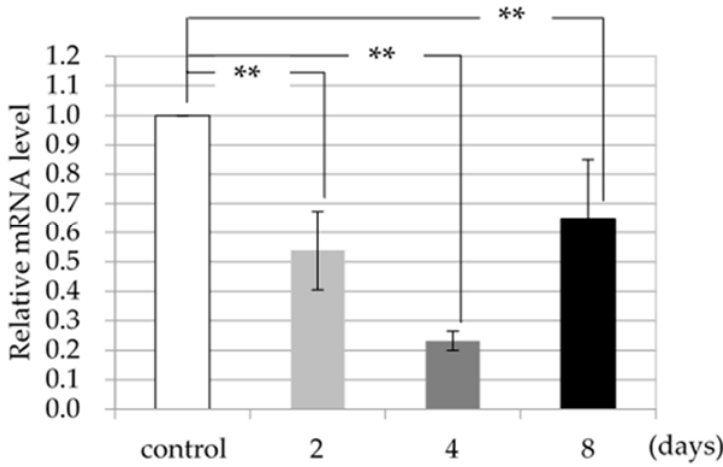
Figure 4. Effect of ISLCs on the gene expression level of IL6 in 3T3-L1 cells 2, 4, and 8 days after differentiation. The IL6 expression level of cultured cells treated with 1.0 mg/mL ISLCs and untreated control cells 2, 4, and 8 days after differentiation was measured by real-time PCR. The cells were cultured in medium containing 1.0 mg/mL ISLCs. The cells in the medium without ISLCs were used as a control. Gene expression was expressed relative to untreated control cells (1.0). The mRNA levels of the target genes were normalized to the values of GAPDH. Values are expressed as the mean ± SD; ** p < 0.01, compared to control cells. 4. Discussion In this study, we investigated the effects of ISLCs on lipid accumulation in 3T3 ‐ L1 adipocytes. The results reveal that the addition of 1.0 mg/mL ISLCs to the culture me ‐ dium was associated with significantly less lipid accumulation compared to untreated controls; thus, ISLCs may contain components that inhibit lipid accumulation in adipo ‐ cytes (Figure 1). Furthermore, the GDPH activity in fully differentiated cells was de ‐ creased compared to that in treated cells (Figure 2). GPDH is known to be an enzyme involved in adipogenesis in fat cells. In this study, the GPDH activity was decreased in ISLC ‐ treated cells, which suggests that ISLCs might have an inhibitory effect on lipo ‐ genesis in adipocytes. IL6 has multiple effects on adipose tissue. Chronically high levels of IL6 may alter gene or protein expression, thus influencing basal lipolysis [14]. Moreover, high local concentrations of IL6 can modulate leptin production and lipid metabolism in human adipose tissue [15,16]. IL6 may also directly influence human adipocyte metabolism by decreasing LPL activity, according to studies on the 3T3 ‐ L1 adipocyte model system [17,18]. In this study, the IL6 expression of 3T3 ‐ L1 cells was decreased and the adipocyte LPL activity was increased following ISLCs treatment compared with untreated controls (Figures 3 and 4). Thus, ISLC ‐ related factors might suppress IL6 expression and indi ‐ rectly affect LPL activity. IL6 is thought to be a paracrine modulator of adipose tissue in obese human beings because LPL activity is inhibited by an increase in leptin production [19]. Although this study did not assess leptin levels, we postulate that the decreased IL6 expression was associated with reduced leptin levels, thereby increasing LPL activity. In conclusion, ISLCs were associated with reduced lipid accumulation in adipo ‐ cytes, with effects on GPDH activity, IL6 expression, and LPL activity, as observed throughout the differentiation period. IL6 is believed to decrease LPL activity and con ‐ trol adipocyte size in humans; however, it is unclear how ISLCs and which specific ISLC components affect IL6 expression. We fractionated the ISLCs extracted at various tem ‐ peratures into functional components and found that only the ISLCs extracted at 100 °C